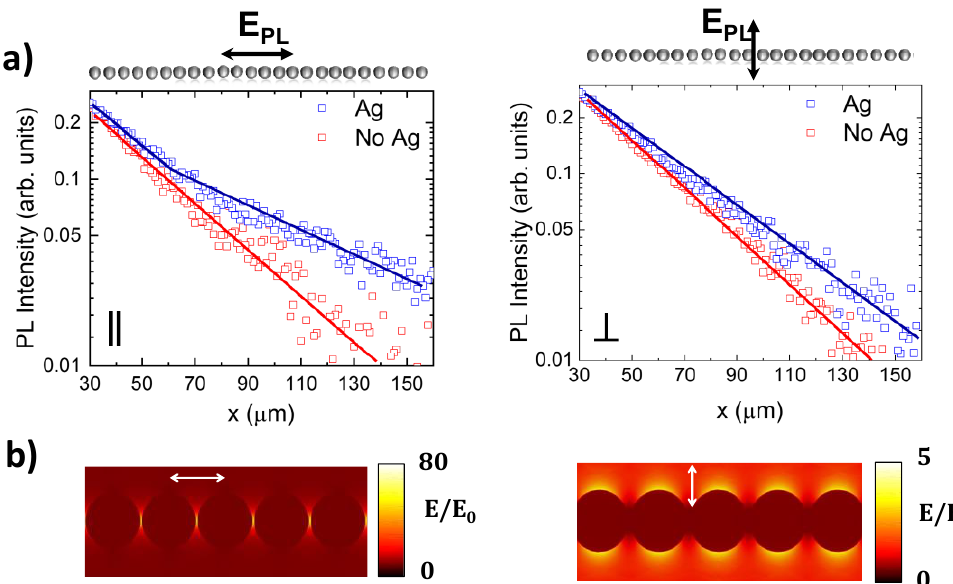
Figure 4. ( a ) Normalized PL intensity profiles associated with the 4 F 3/2 → 4 I 9/2 transition of Nd 3+ for fluorescence that is polarized parallel (left) and perpendicular (right) to the axis of the chain. ( b ) Distribution of the near-field amplitudes at the NP midplane computed at λ em = 890 nm for incident plane wave polarized parallel (left) and perpendicular (right) to the chain.